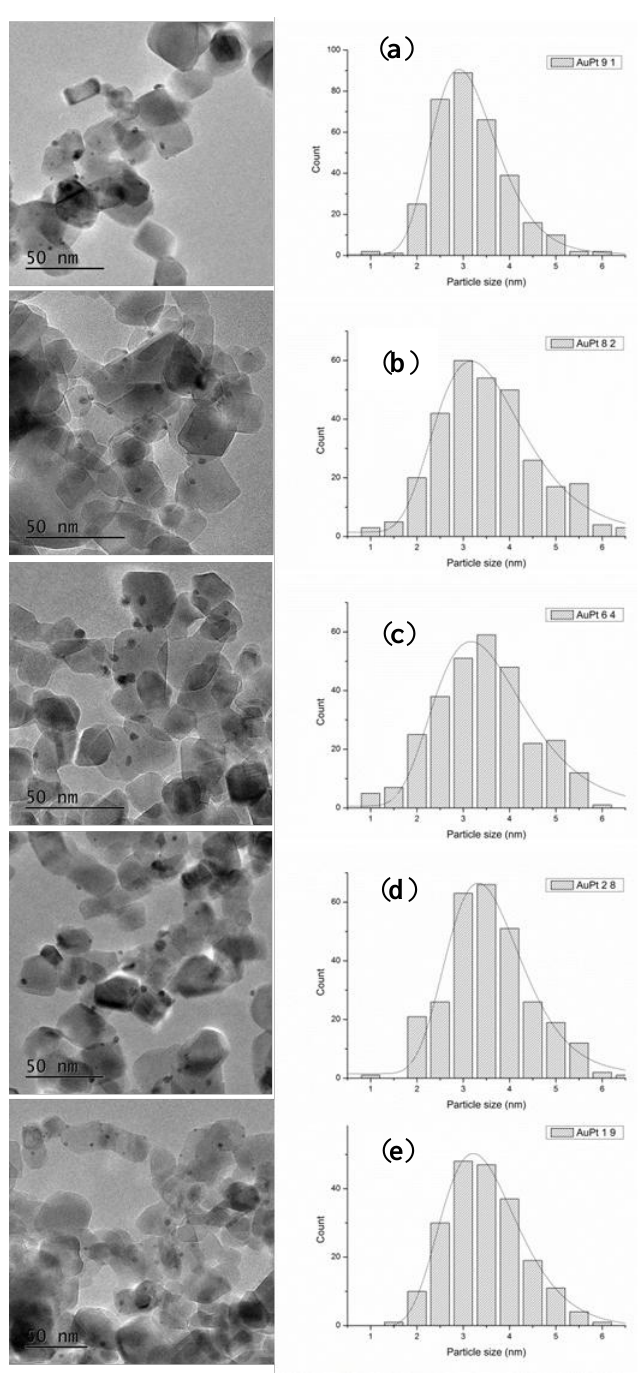
Figure 1. High resolution TEM micrographs (left side and middle) and histogram of particle size distribution (right side) of ( a ) Au 9 Pt 1 /TiO 2 ; ( b ) Au 8 Pt 2 /TiO 2 ; ( c ) Au 6 Pt 4 /TiO 2 ; ( d ) Au 2 Pt 8 /TiO 2 ; ( e ) Au 1 Pt 9 /TiO 2 .